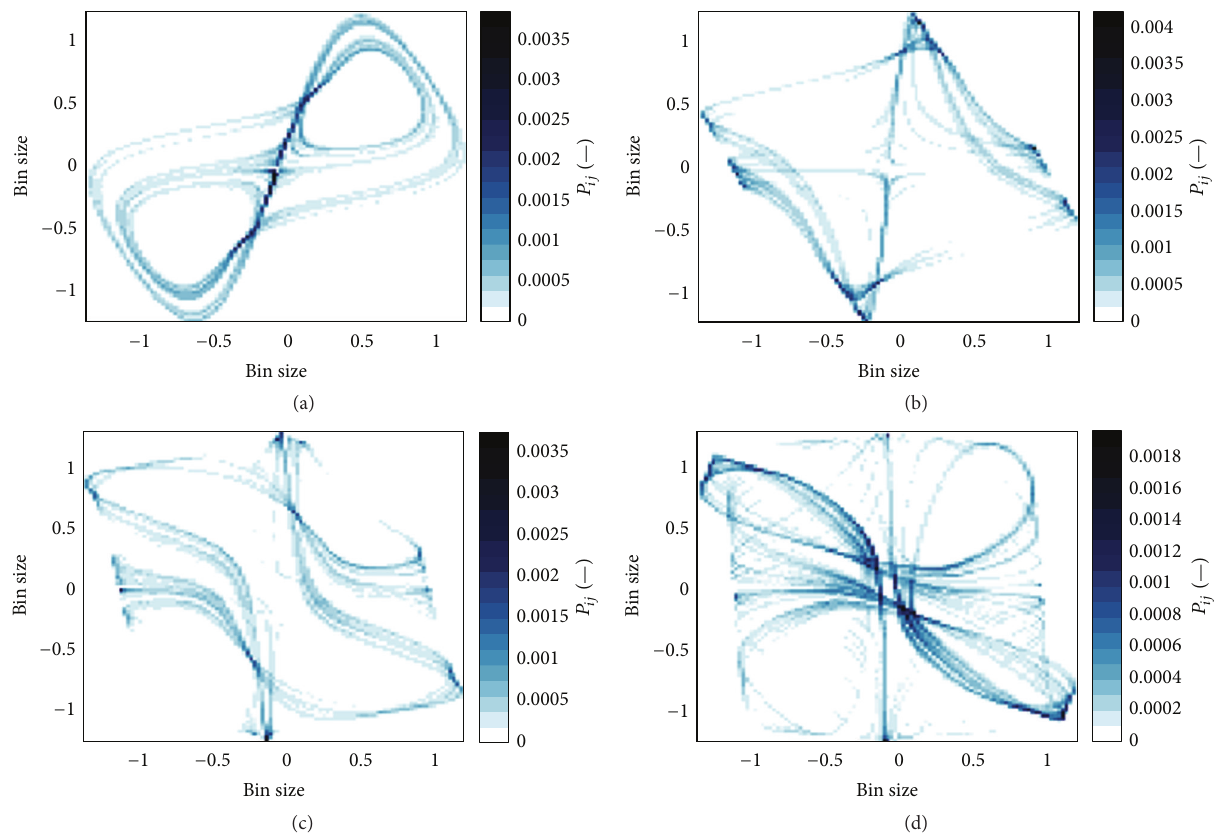
Figure 5: Probability phase space cuts for the Lorenz model: (a) 𝜏 = MIF min ; (b) 𝜏 = 2 MIF min ; (c) 𝜏 = 3 MIF min ; (d) 𝜏 = 4 MIF min